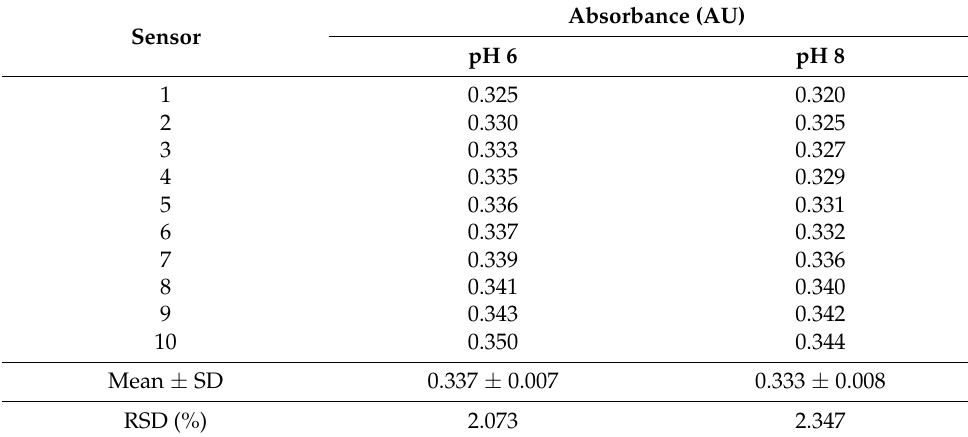
Table 1. Reproducibility of sensors tested at pH 6 and